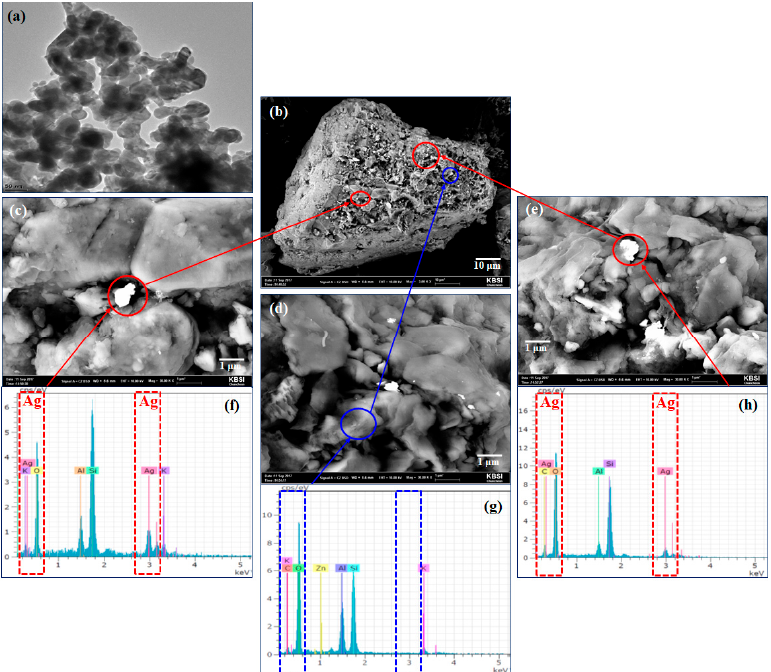
Figure 1. Field-emission transmission electronic micrograph (FE-TEM) of silver nanoparticles (AgNPs) ( a ) and high-resolution scanning electron microscopy (HR-SEM) images of AgNPs in 100 mg AgNPs/kg (dry weight) test soil. Adsorption of AgNPs on the soil surface was assessed with an energy-dispersive X-ray spectroscopy (EDX). ( b – e ) are HR-SEM images and ( f – h ) indicate EDX spectra of an electron dense spot. The red circles show the presence of AgNPs on the soil surface and blue circles show absence of AgNPs in the normal soil.